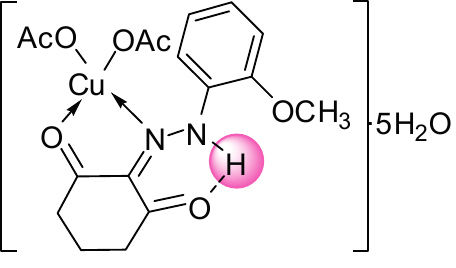
Figure 2. Structure of [(CuL 1 )(OAc) 2 ]·5H 2 O